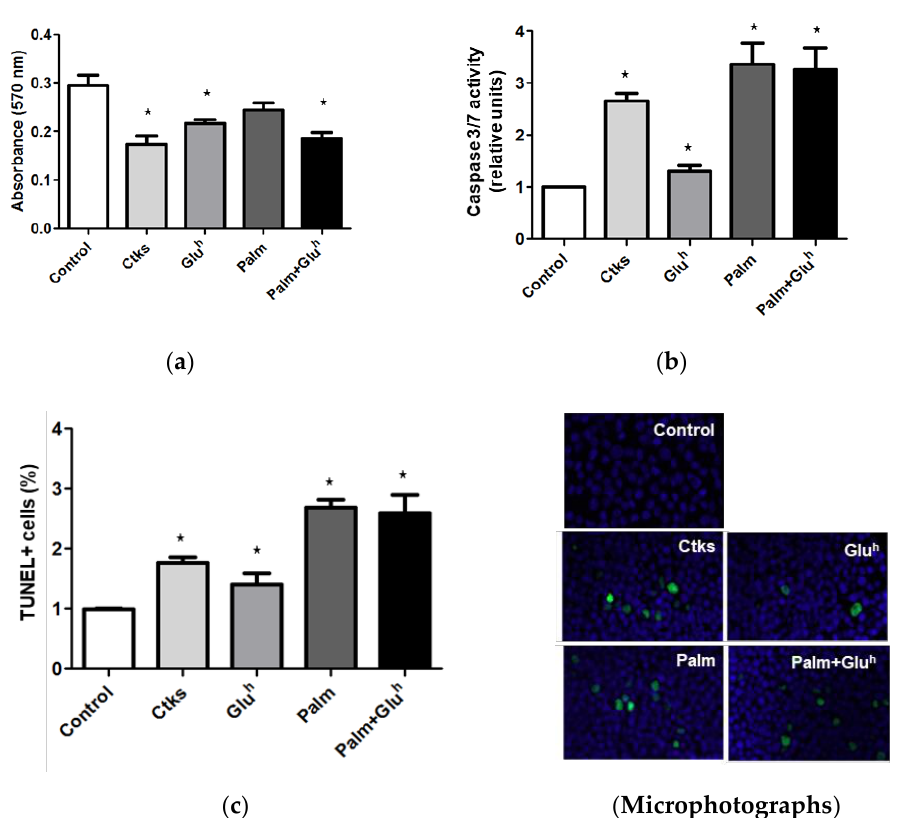
Figure 1. Cytokines, palmitate, high glucose, and high glucose+palmitate effect on the 1.1E7 cell survival. MTT assay for cell viability ( a ), Caspase Glo luminescence kit for caspase 3/7 activity ( b ) and TUNEL assay for apoptosis quantification ( c ) were performed to 48 h cultured 1.1E7 cells in the presence of cited stimuli. Microphotograhs are representative images of TUNEL stained cells counterstained with DAPI. Values are represented as mean ± SEM of four independent experiments. * p < 0.05 with to respect the control condition.